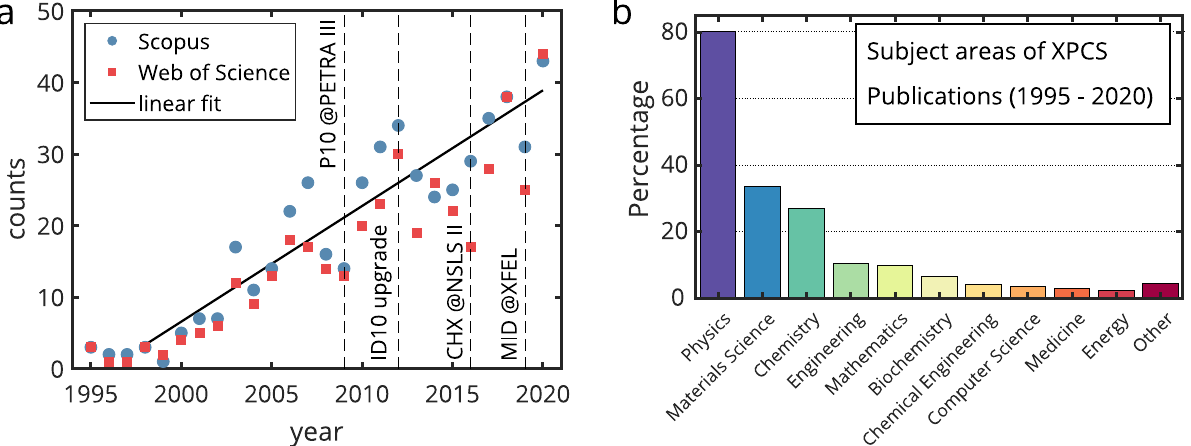
Figure 2. ( a ) Publications mentioning X-ray photon correlation spectroscopy (XPCS), X-ray speckle visibility spectroscopy (XSVS) or X-ray intensity fluctuation spectroscopy (XIFS) as keyword, in the title or abstract. The solid line models a linear increase of the SCOPUS data between 1998 and 2020 with an increase rate of 1.62 publications per year. The dashed lines mark the years where new beamlines with XPCS dedication became online. ( b ) Distribution of subject areas of XPCS publications from 1995 to 2020. For each publication multiple areas are